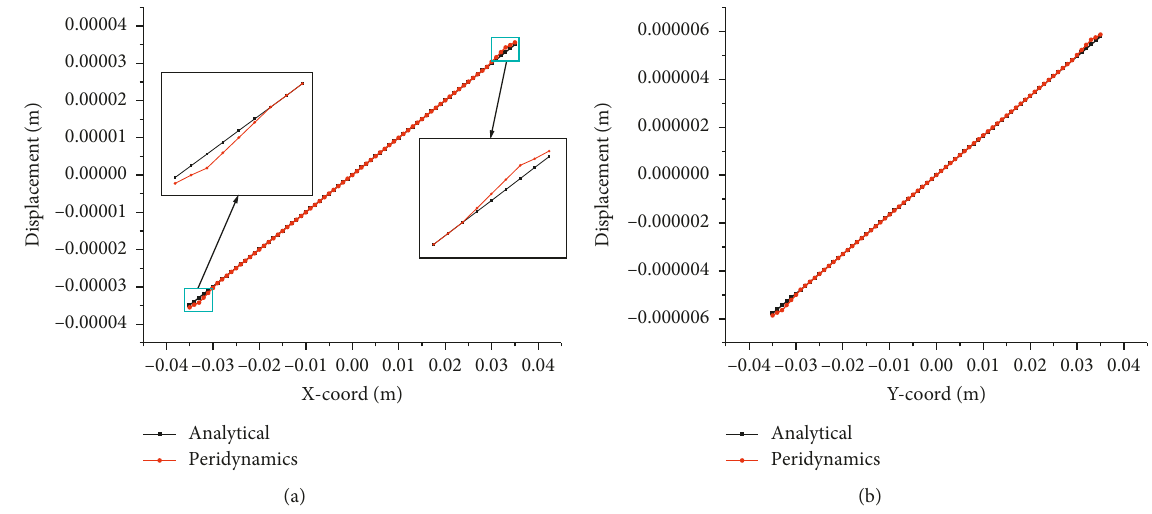
Figure 13: Comparison of displacement between PDLM and analytical results. (a) Horizontal displacement. (b) Vertical